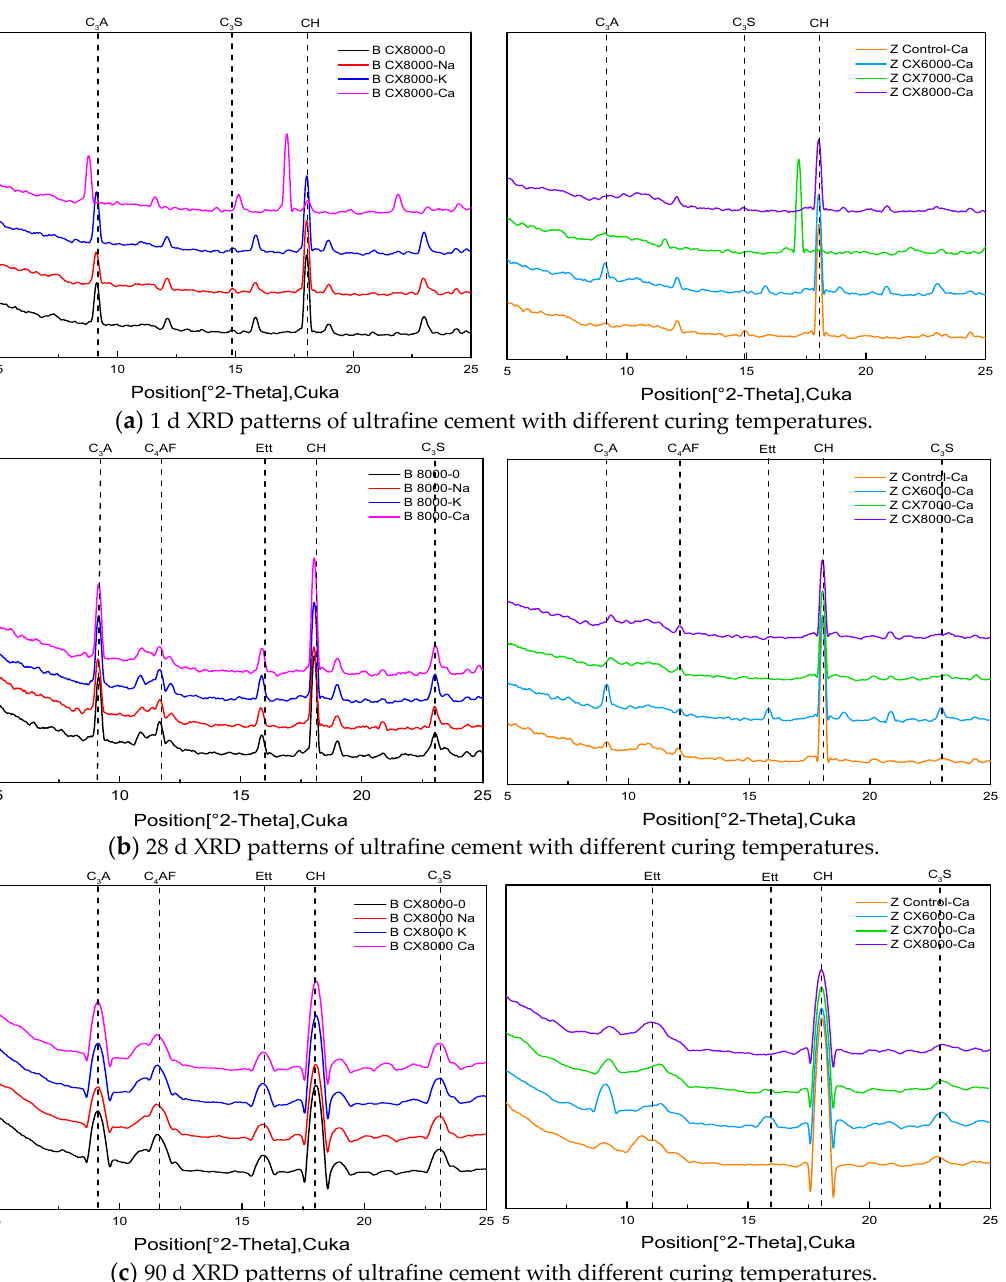
( c ) 90 d XRD patterns of ultrafine cement with different curing temperatures. Figure 7. XRD analysis of ultrafine cement system at different